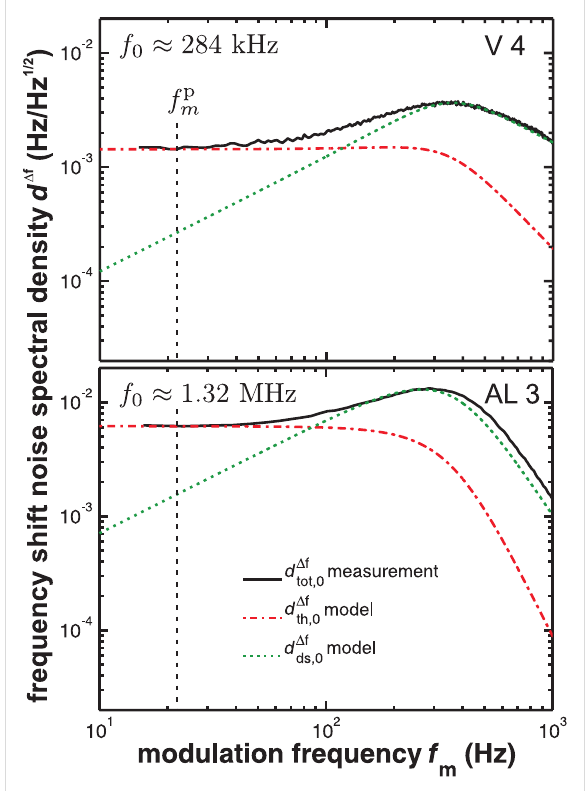
Figure 3: Frequency shift noise spectral density measured for cantilever V 4 ( A 0 = 16.8 nm, demodulator bandwidth B − 3dB = 415 Hz) and cantilever AL 3 ( A 0 = 16.5 nm, demodulator bandwidth B − 3dB = 258 Hz). Spectra are recorded with at least 1000 averages. Dotted lines show the contribution of the detection system noise floor; dash-dotted lines represent the contribution of the thermal noise to the total frequency shift noise . The analysis of the noise spec- tral density at the plateau frequency yields the cantilever stiffness according to Equation